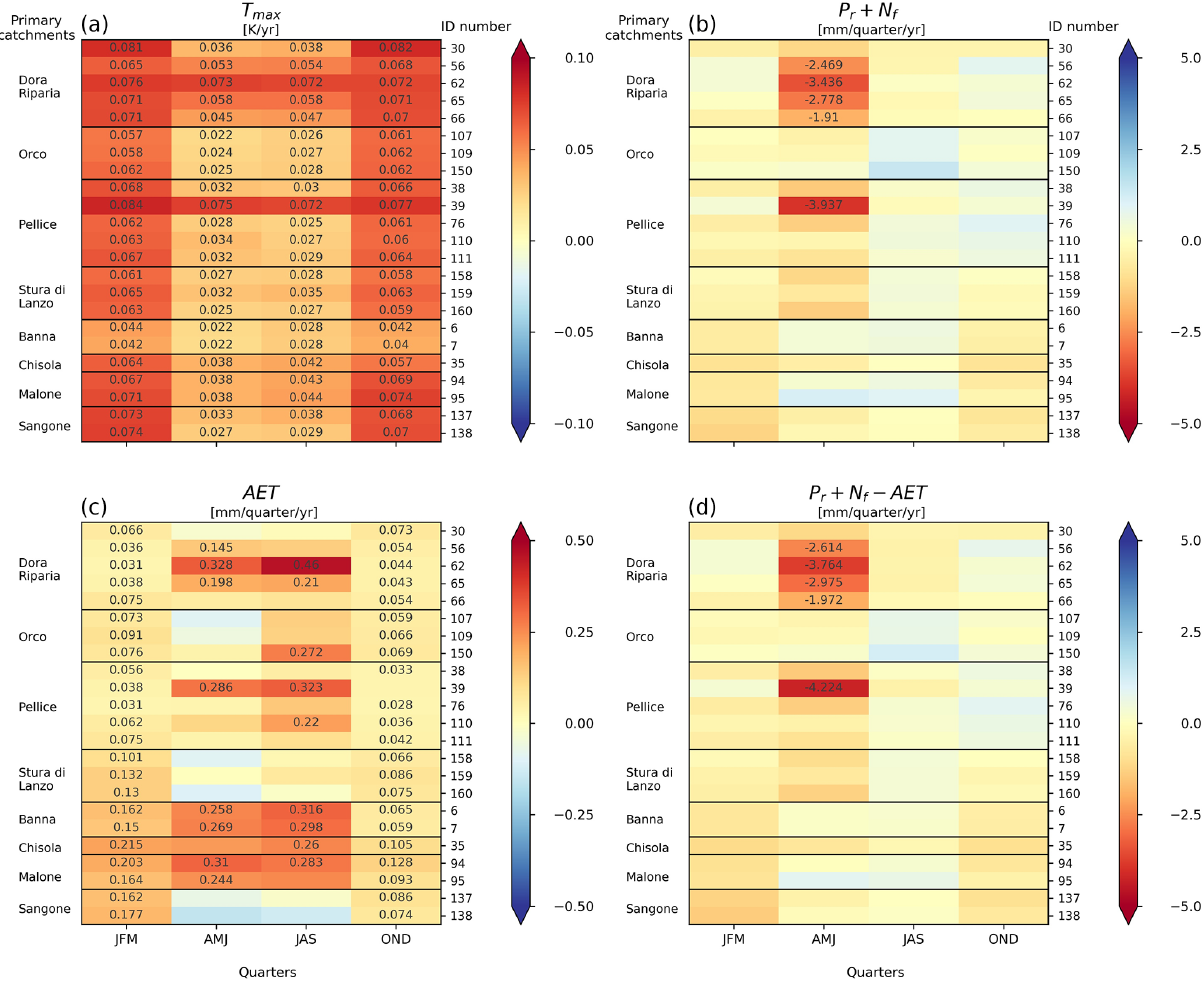
Figure 5. Trend slope of all quarters and catchments considered. (a) T max , (b) precipitation, (c) AET and (d) drainage. Trend slope is specified if significant at a 5% level. When quarters are considered, the precipitation is represented by the sum of liquid precipitation P r and melted snow N f